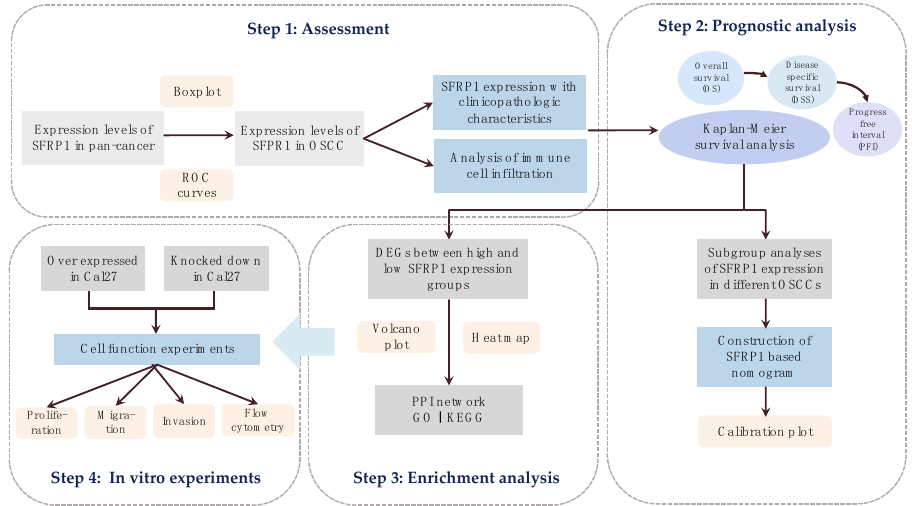
Figure 1. Flow chart of data analysis and experimental design.